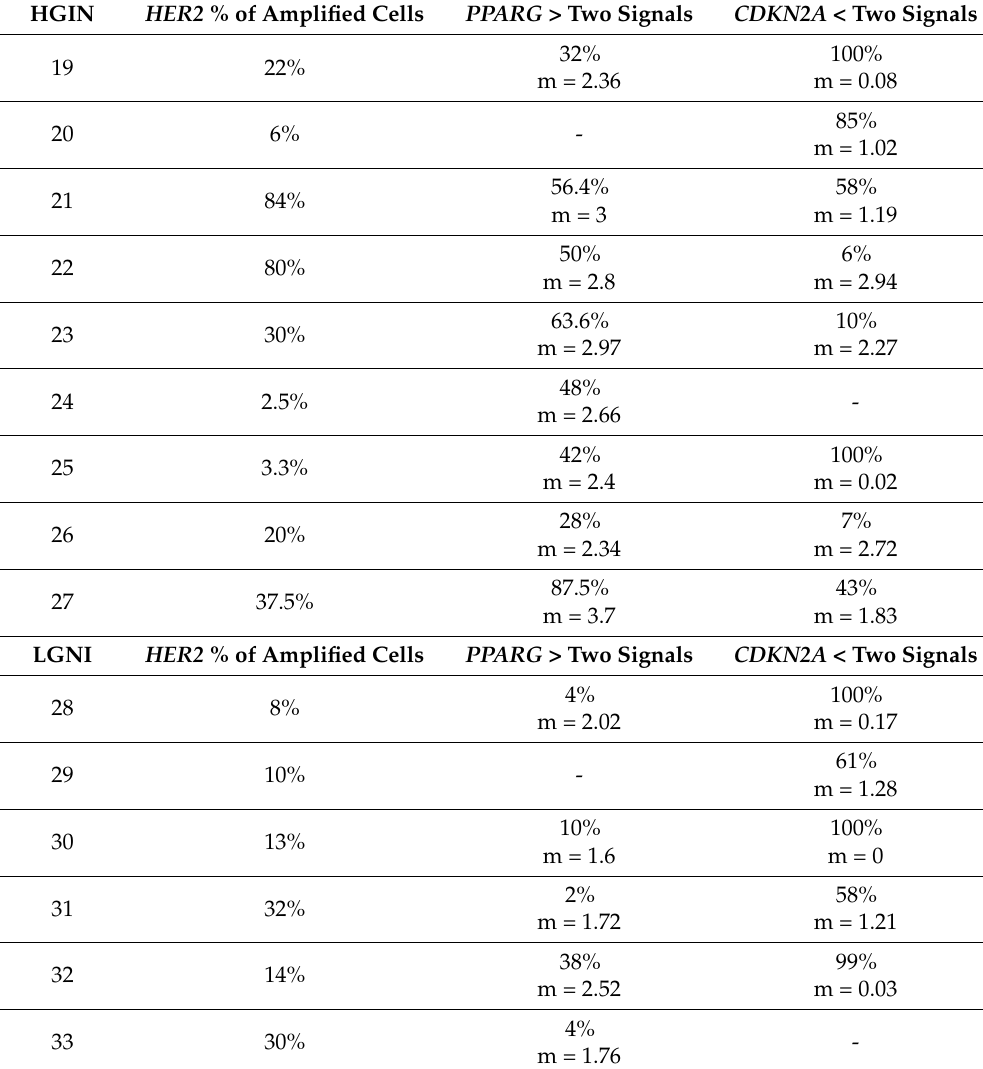
Table 2. Fluorescence in situ hybridization (FISH) on formalin-fixed, paraffin-embedded (FFPE) tissues. HGIN HER2 % of Amplified Cells PPARG > Two Signals CDKN2A < Two